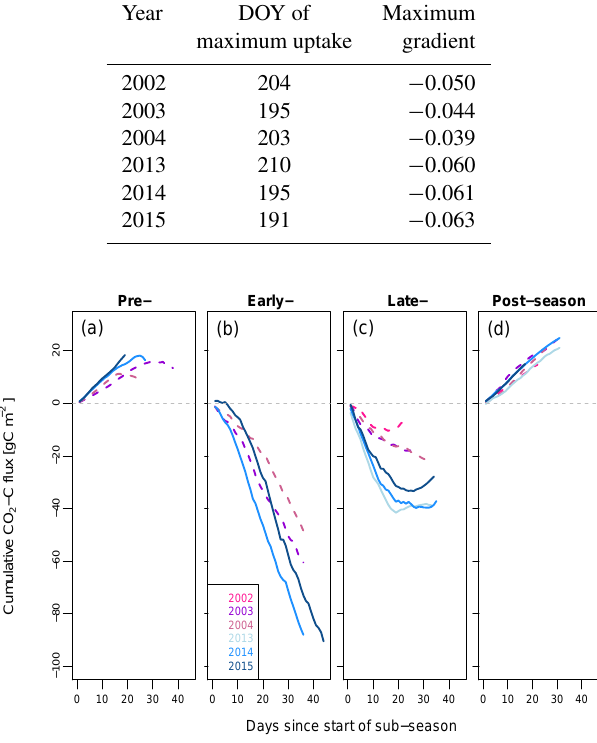
Figure 9. Sub-seasonal CO 2 flux budgets for the control area for the historic (2002–2004) and recent (2013–2015) datasets. Time axes within this plotting scheme are identical to those used in Fig.